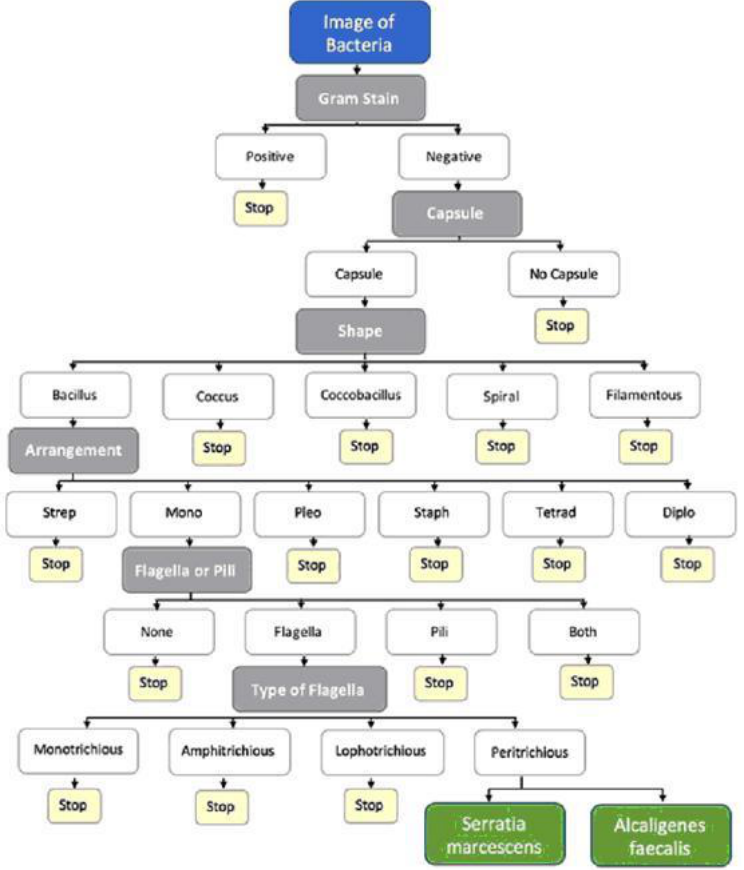
Figure 6. Typical decision matrix drop down menu with 5 branches for automated pathogen iden- tification.